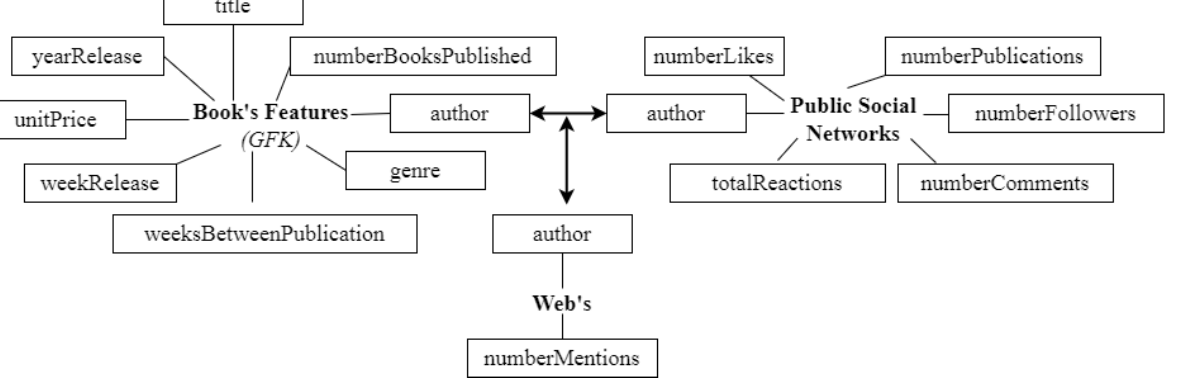
Figure 1. The entity–relationship diagram of the various sources works to form the input dataset to the proposed system. The two-way arrows indicate that author is the key to the union between the different